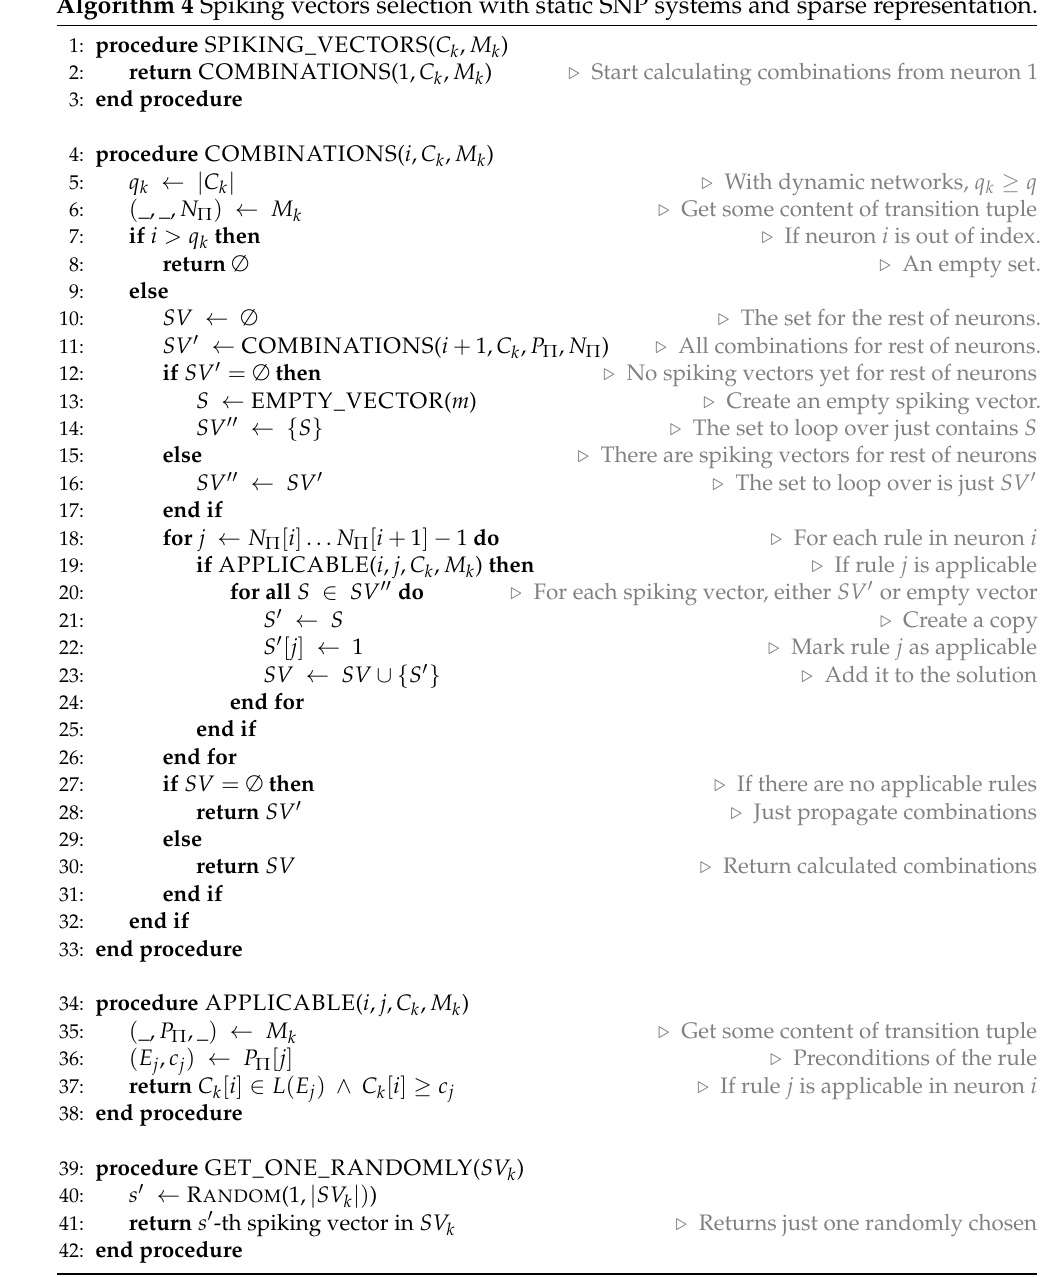
Algorithm 4 Spiking vectors selection with static SNP systems and sparse